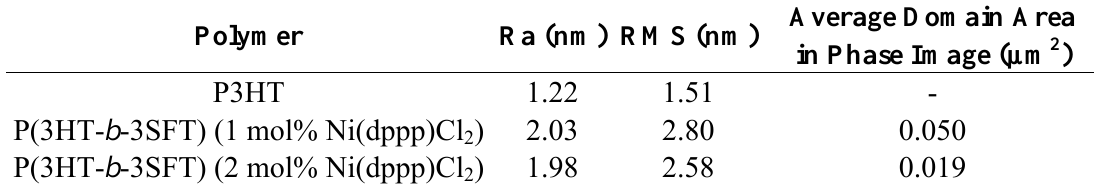
Table 2. The roughness of films from atomic force microscopy ( AFM)